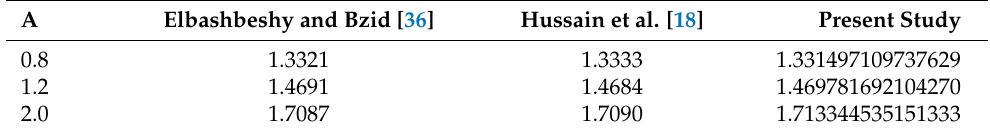
(cid:0) (cid:1) R d θ (cid:48) ( 0 ) compared with published results and Matlab 1 + 4 3